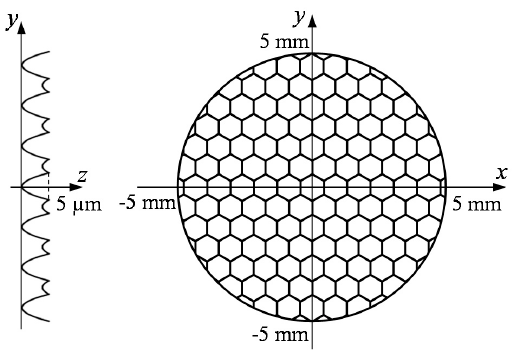
Figure 3. Lens array design for cutting experiments of comparison between segment turning and continuous turning.